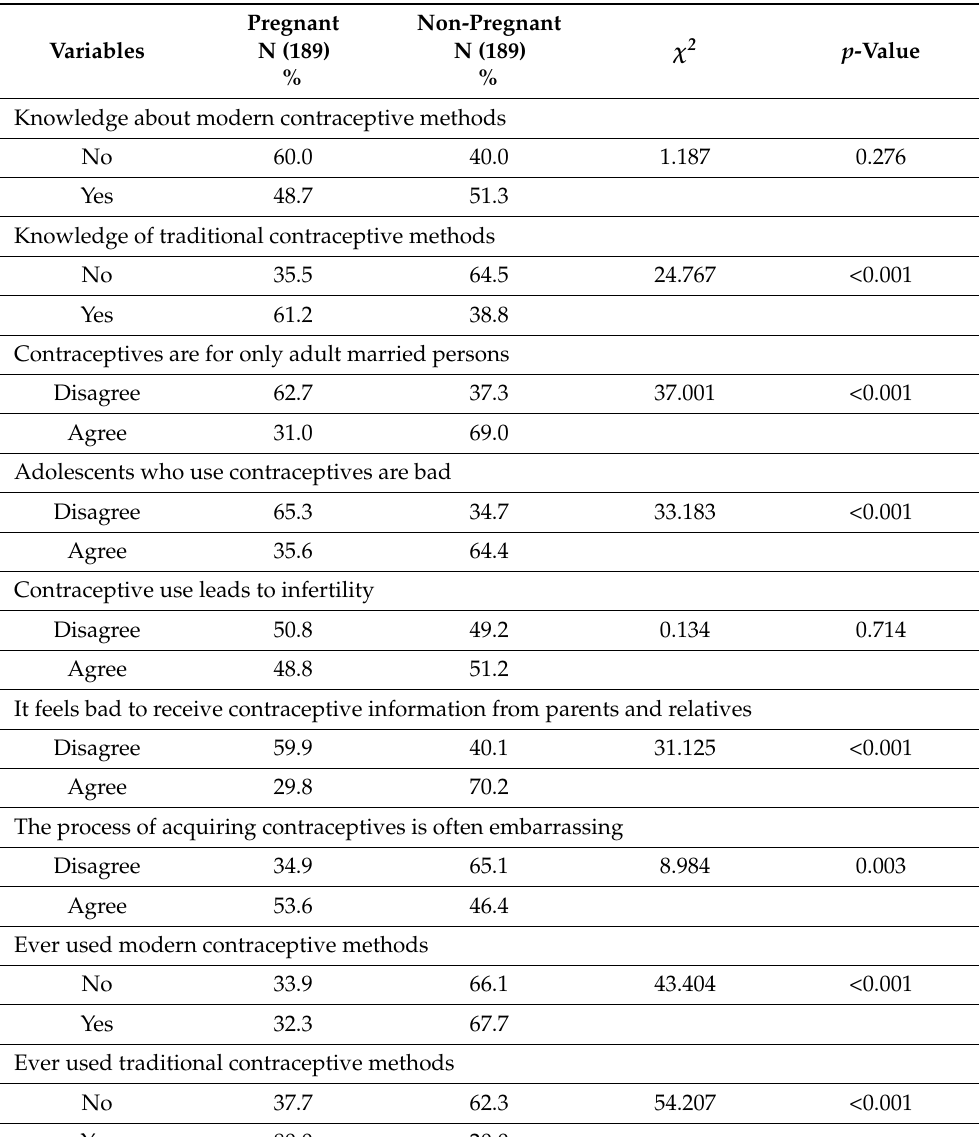
Table 1. Distribution of Adolescent Pregnancy across Knowledge, Attitudes, and Use of Contracep-